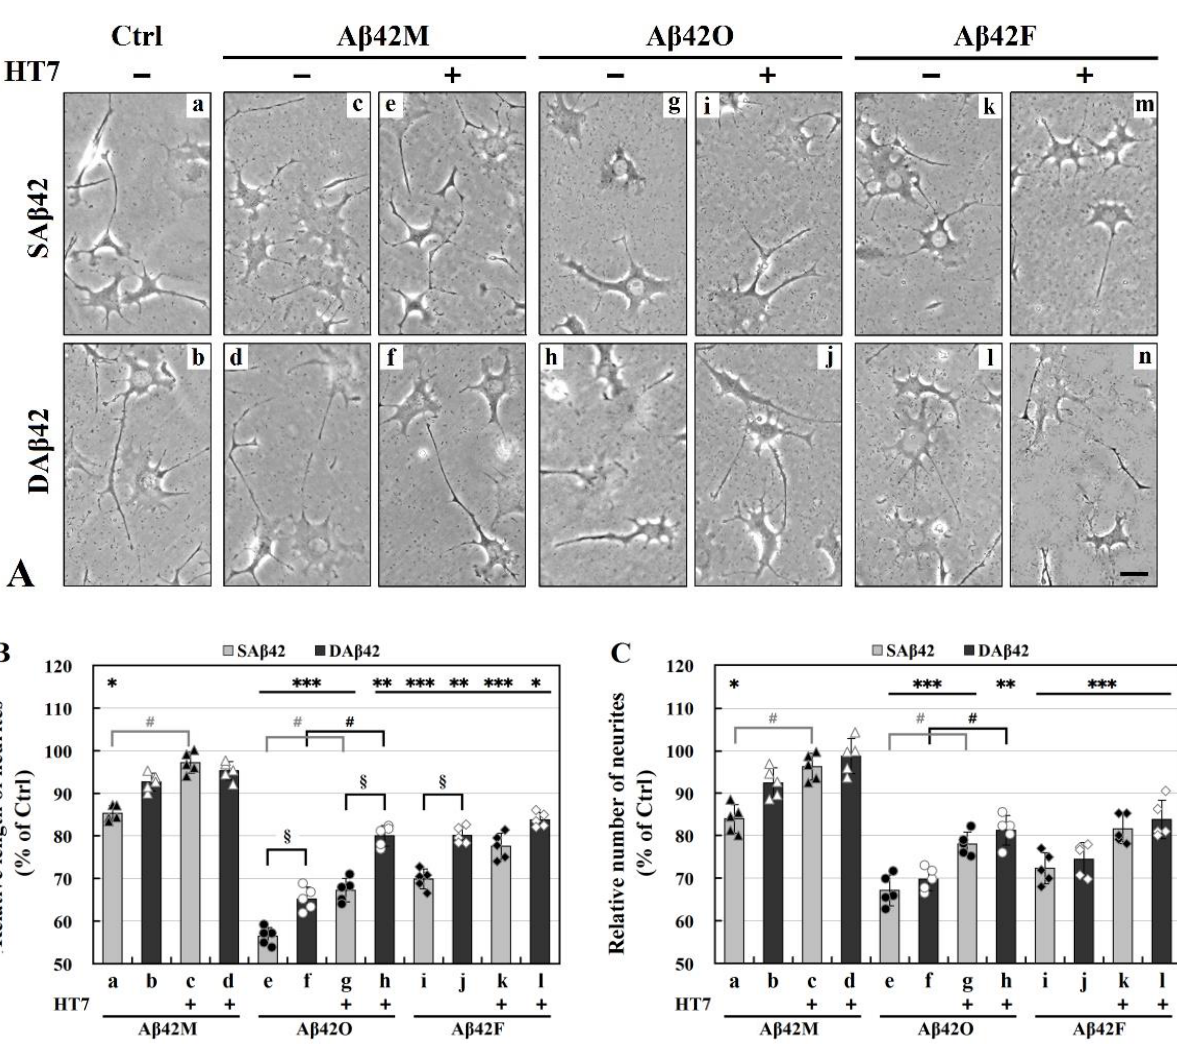
Figure 3. Analysis of neurite outgrowth of differentiated SH-SY5Y cells in the presence of extracellular A β 42 or its aggregates with or without HT7 for 24 h. ( A ) Representative images of differentiated SH-SY5Y cells. The images represent enlarged partial regions of the representative whole images shown in Figure S1. No difference between control and HT7 alone (not shown). ( B , C ) Relative length and number of neurites of differentiated SH-SY5Y cells, with those in the control group as 100%. * p < 0.05, ** p < 0.01, or *** p < 0.001, between A β 42-treated and the corresponding control groups. § p < 0.05, between SA β 42O/F- and DA β 42O/F-treated subgroups. # p < 0.05, between A β 42O/F-treated groups with and without HT7 (or HT6) antibody. Differences between the Ctrl and HT7 (or HT6) (not shown) groups were not significant ( p > 0.05). Scale bar = 200 µ m. However, the quantitative data from e – h of Figure 3B,C showed that most of the cells treated with either extracellular SA β 42O/DA β 42O and SA β 42F/DA β 42F failed to achieve a normal length and/or number of neurites, indicating that extracellular A β 42 aggregates caused a dramatic decline in neurite length and number (* p < 0.05, ** p < 0.01, *** p < 0.001); similarly, the damage effects of these extracellular A β 42 aggregates could be inhibited or blocked to some extent by the anti-oligomeric A β 42 antibody HT7 (# p < 0.05). Evidently, the damage effects of the extracellular A β 42 aggregates on neurite occurrence and extension were positively correlated with their neurotoxicity. On the other hand,